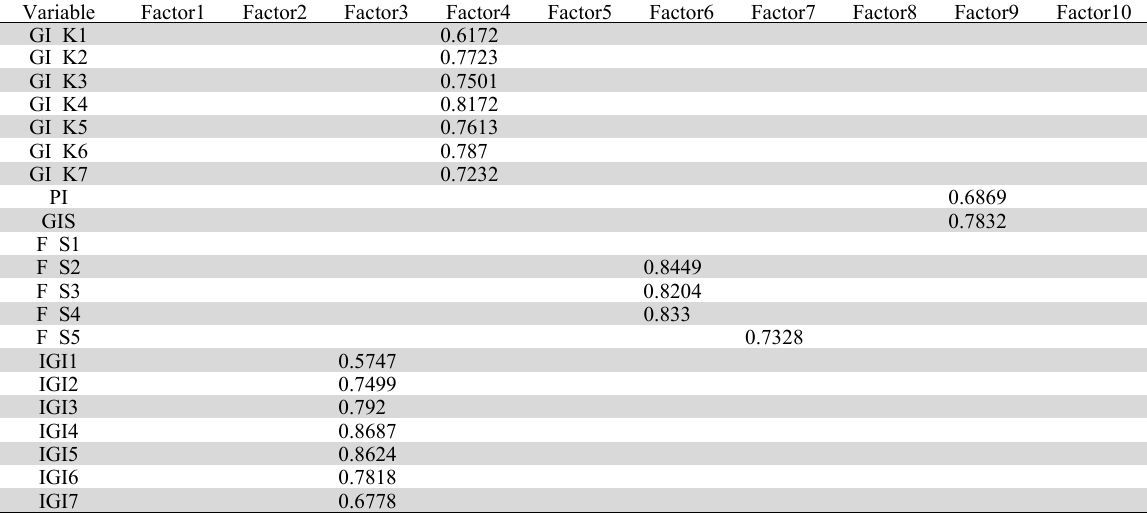
Factor loading of elements that affect green investment